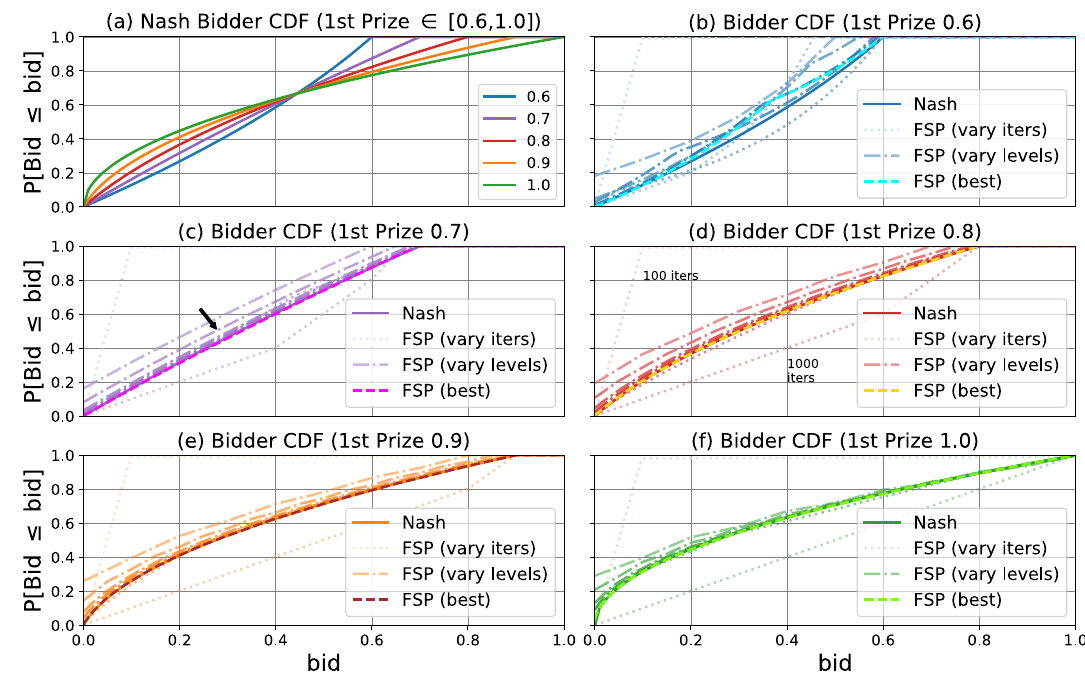
Figure 8. Bidder CDF comparison. ( a ) shows the CDFs for each of five different auction designs assuming the bidder plays the Nash distribution. The first prize is listed in the legend; the second prize equals one minus the first; no prize is given to the third bidder. The remaining plots compare the Nash CDF with the CDF learned by Fictitious Self-Play for different first prize amounts. ( b )–( f ) Show the effect of training iterations and discretization granularity on the final CDF. The arrow in ( c ) highlights a common trend where the CDF converges to Nash from above as a finer discretization is introduced: coarser discretizations lead to under bidding and, in turn, underestimates of the auctioneer utility. ( d ) Shows that increasing training iterations reduces error, but in a less structured manner than bid